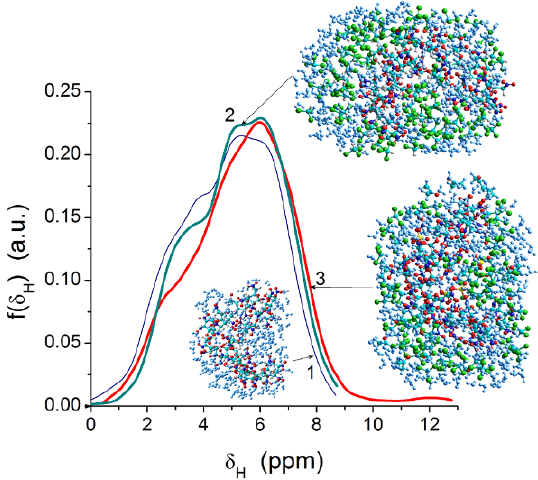
Figure 9. Calculated 1 H NMR spectra (PM7 with the calibration function) of water molecules (177H O (curve 1), 364H O 2 2 (2) or 281H O (3)) bound to two NC fragments with 2 400 atoms (1) without and with co-adsorbed molecules of (2) chloroform (50 molecules) and (3) chloroform (50 molecules), acetone (20 molecules), nitric (four molecules) and sulfuric (four molecules)